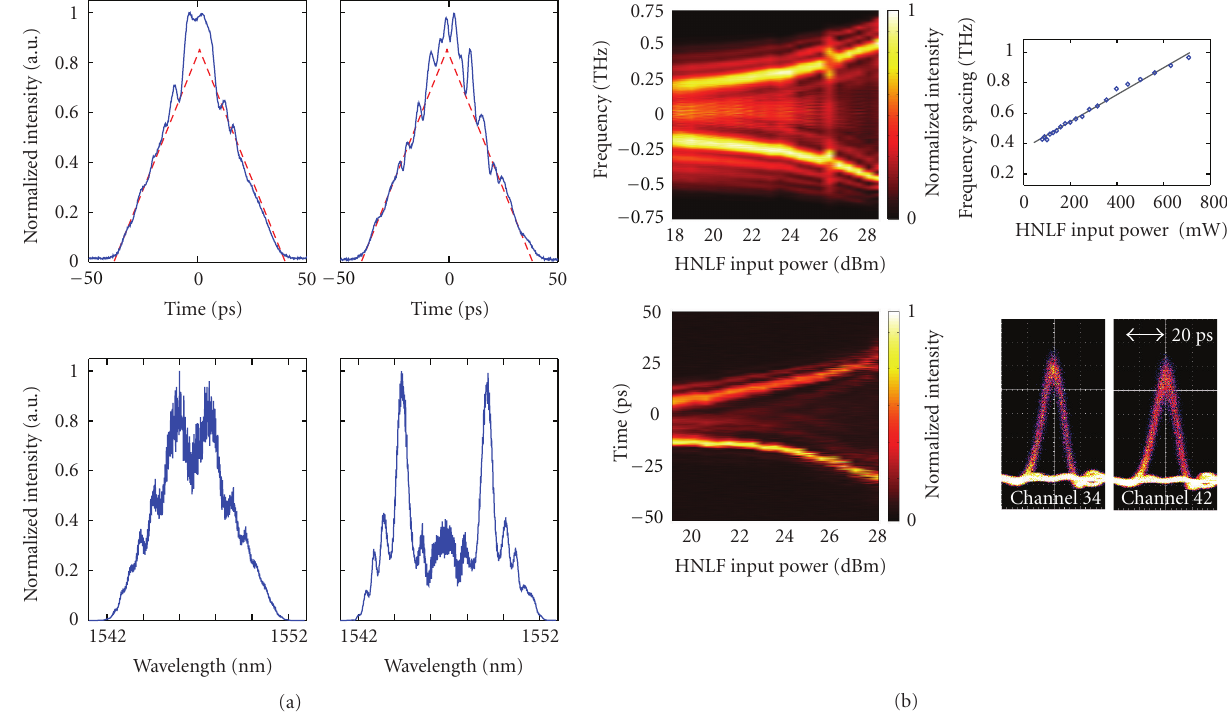
Figure 8: (a) Temporal (top) and spectral (bottom) intensity profiles after the ND reshaping fibre (left) and after the HNL fibre (right). (b) Top, evolution of the output spectrum from the HNL fibre with the input power (left) and dependence of the frequency spacing between the two spectral peaks on the input power (right). Bottom, evolution of the temporal intensity profile at the output of the linear SM fibre with the input power to the HNL fibre (left) and eye diagrams of a 10Gbit/s pulse train obtained after spectral filtering for the ITU channels 34 and 42. Results adapted from